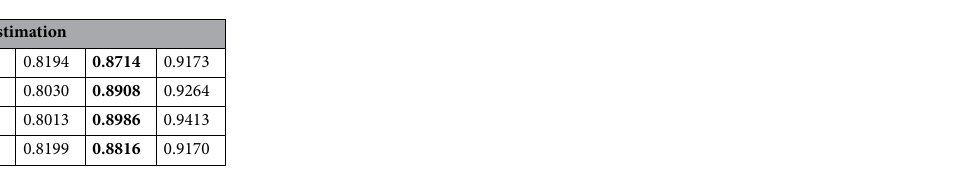
Table 3. Results of payload estimation (full sensor configuration): first quartile, median value (bold font), and third